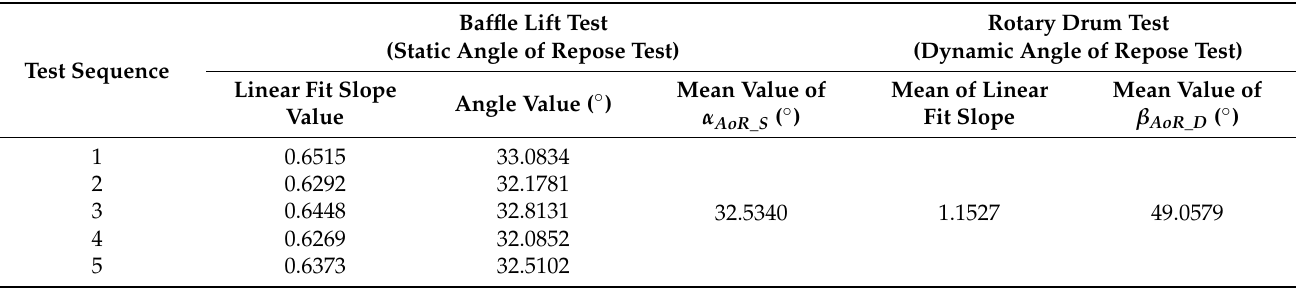
Table 1. Experimental results of the angle of